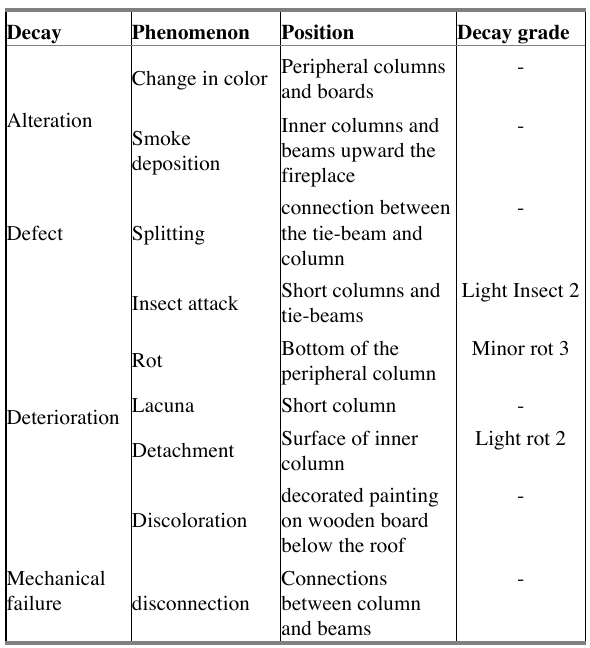
Table 3 . Damage classification in wood components